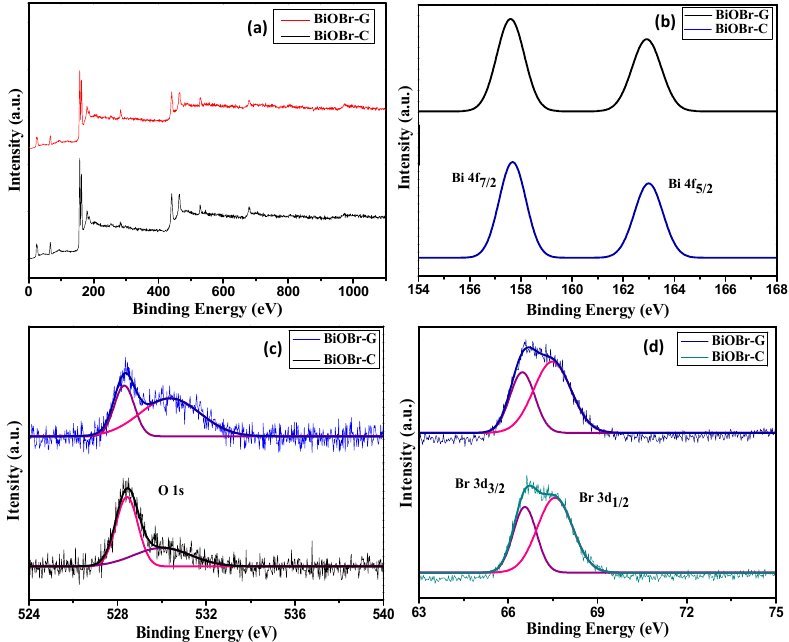
Figure 2. XPS spectra ( a ) Survey of the samples, ( b ) Bi 4f, ( c ) O 1s, and ( d ) Br 3d, of BiOBr ‐ C and BiOBr ‐ G.